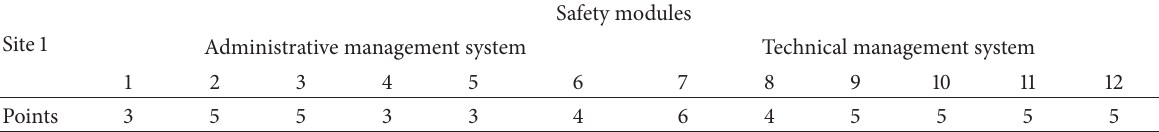
Table 2: Element wise points for site 1.